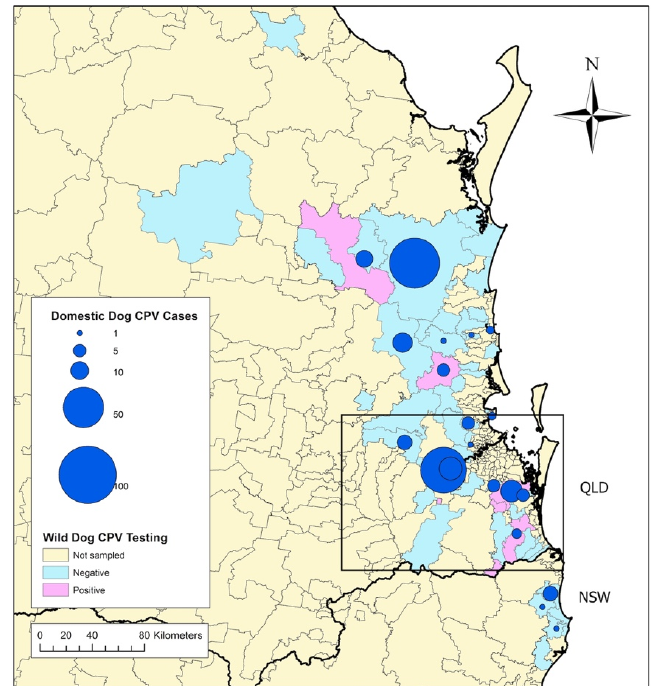
Figure 2. Distribution and frequency of canine parvovirus cases in domestic dogs reported by veterinarians on the Disease WatchDog ® national disease surveillance system between 2009 and 2015, and postcodes where wild dogs, sampled between 2012 and 2015, tested positive or negative to canine parvovirus as determined by polymerase chain reaction. Map represents South East Queensland (QLD) and Northeast New South Wales (NSW), Australia. Inset depicts area represented in Figure 3.